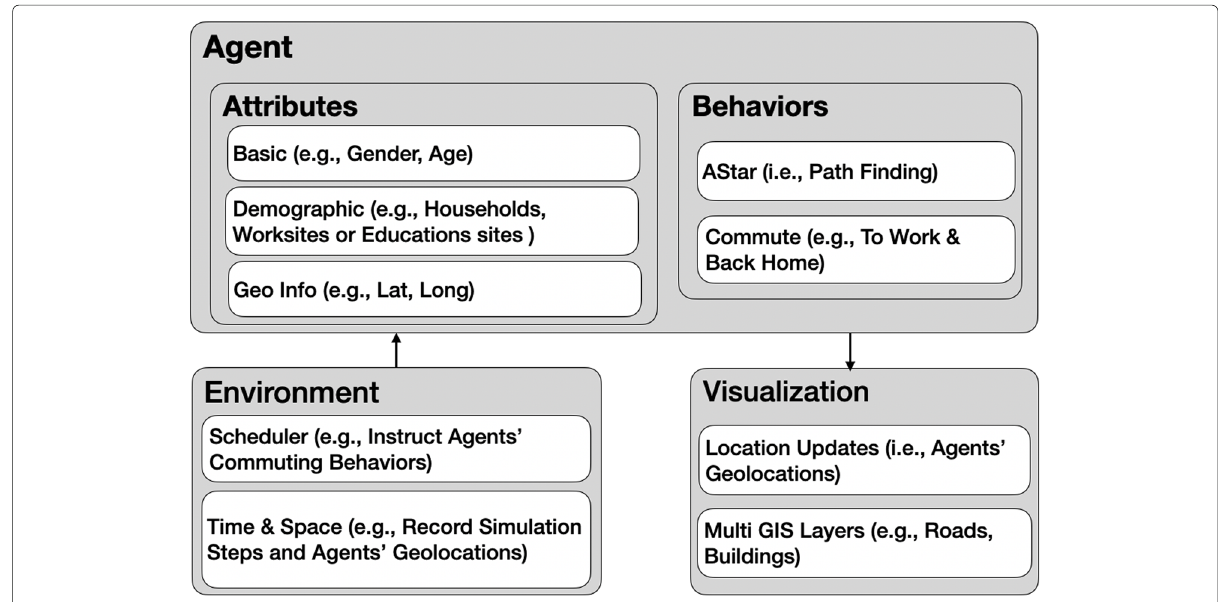
Fig. 9 Traffic Dynamic Model Component